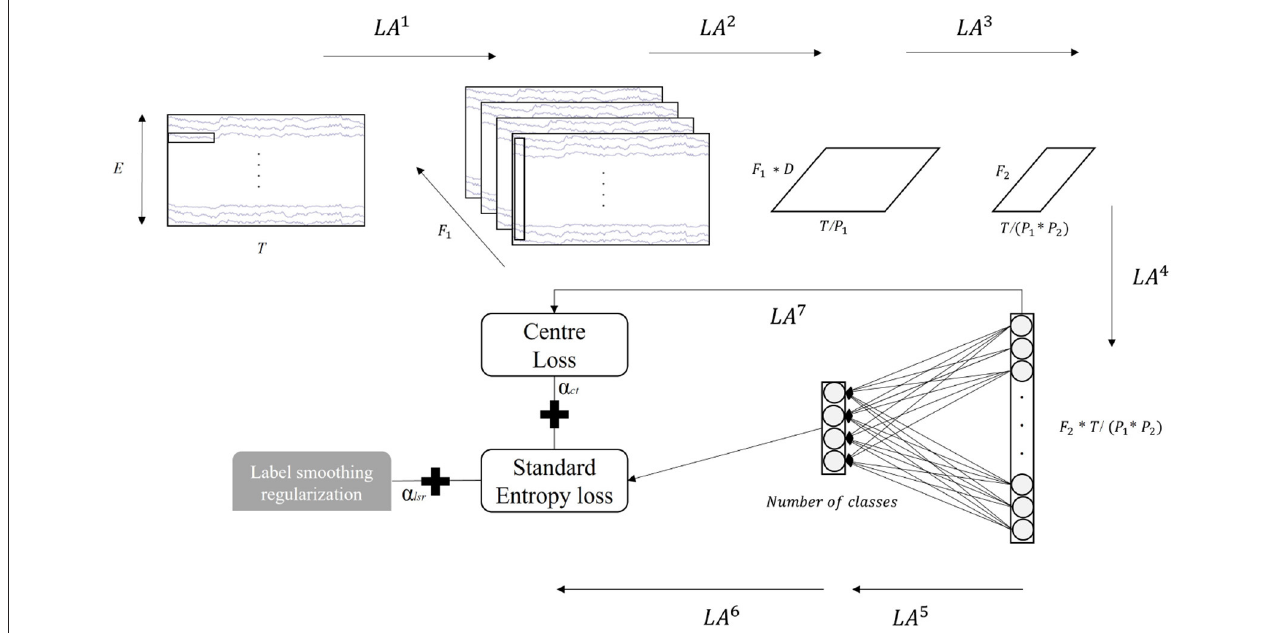
FIGURE 2 | Illustration of the convolutional neural network (CNN)-based model. T = number of the timestamps, E = number of electricodes, F 1 = number of filters in the temporal CNN, D = number of depthwise convolution output channels, F 2 = number of spatial filters, P 1 and P 2 are sizes of the average pooling kernel, and α lsr and α ct are weights of label smoothing regularization and center